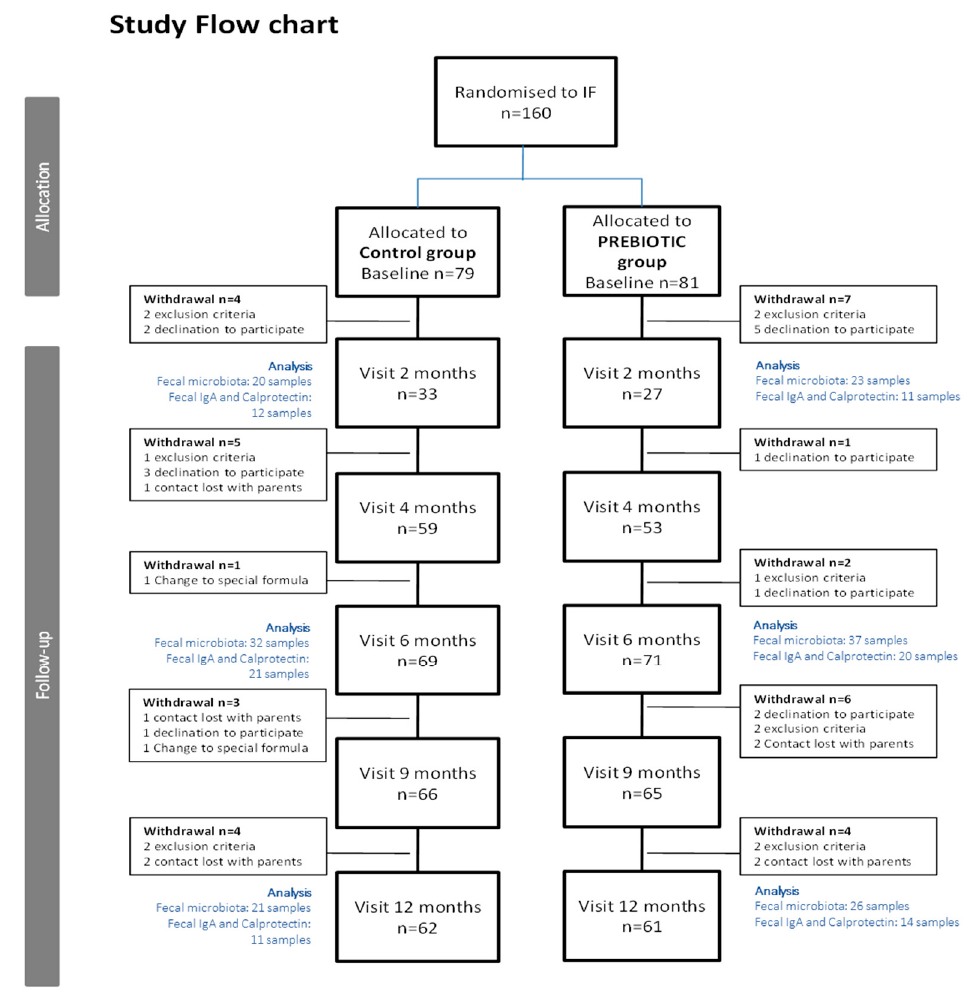
Figure 1. Flow chart of the infants included in the study (IF = Infant Formulae).